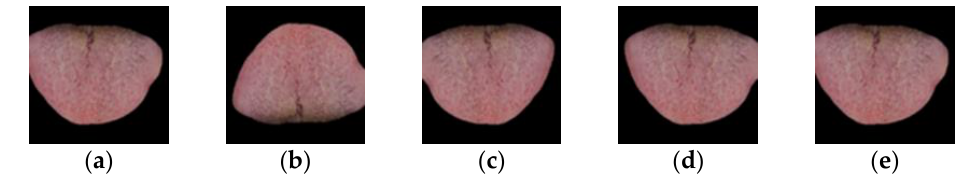
Figure 3. Data augmentation. ( a ) Original image; ( b ) Rotate 90 degrees; ( c ) Rotate 180 degrees; ( d ) Horizontal movement; ( e ) Vertical movement.